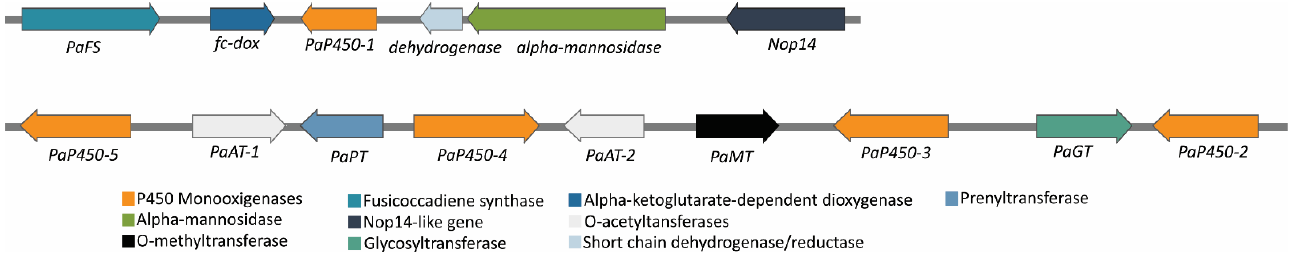
Figure 2. Fusicoccin A biosynthetic gene clusters found in Diaporthe amygdali CAA958. Gray horizontal lines represent genomic sequences. Color-coded arrows represent the predictive function of different genes. Arrows indicate the direction of transcription of the gene.